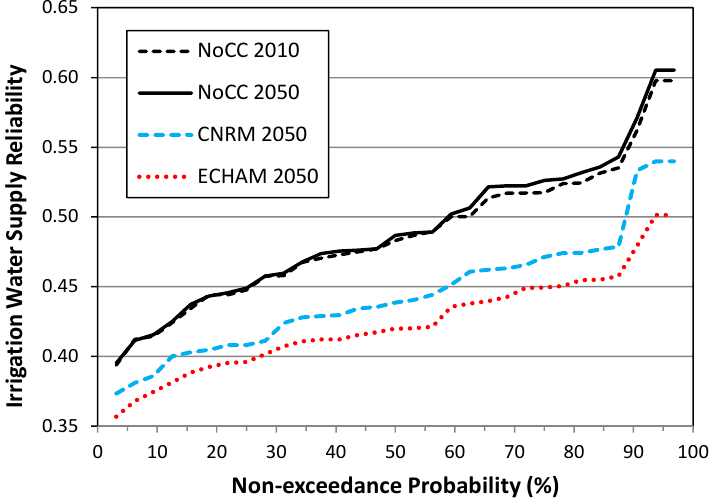
Figure 14. Non-exceedance probability of irrigation water supply reliability in the South African catchment of the Limpopo River Basin under the 1971–2000 climate baseline and two climate change scenarios for